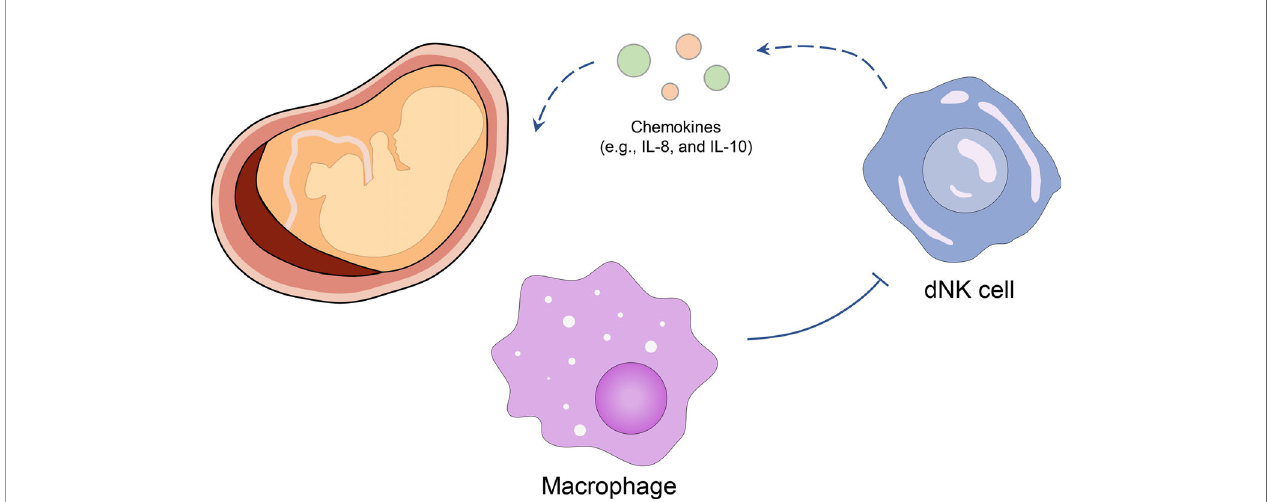
FIGURE 1 | Inhibitory effect of macrophages on dNK cells in the maternal-fetal interface. Macrophages induce the immune tolerance of dNK cells and decrease the chemokines (such as IL-8, and IL-10) in the maternal-fetal interface, thus stabilizing the